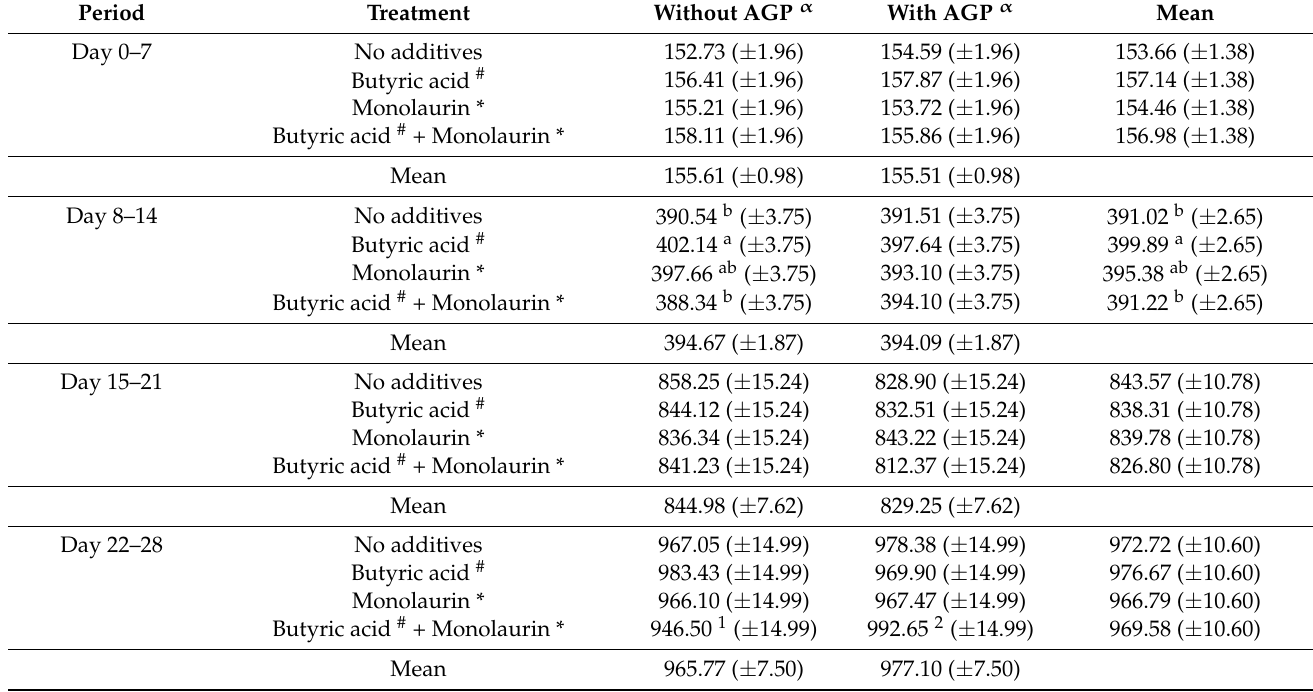
Table 2. The effect of butyric acid and α -monolaurin, with and without the inclusion of an antibiotic growth promoter, on weekly and overall feed intake of broilers ( ± standard error of the